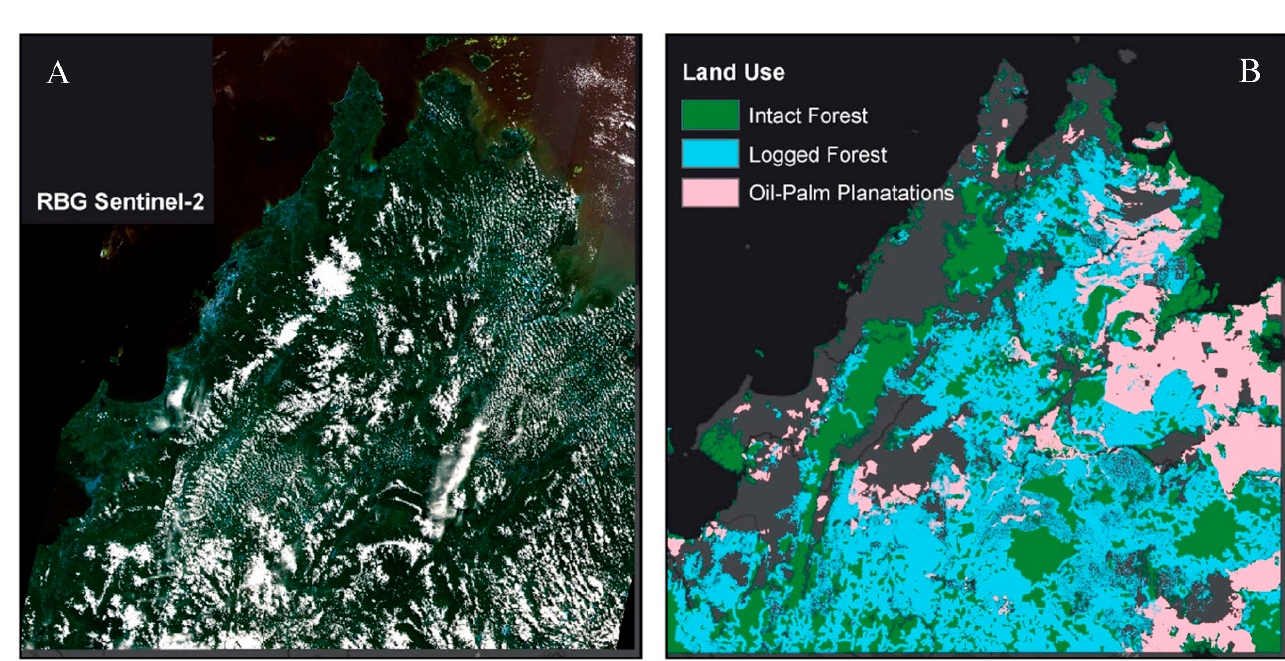
Figure A1. ( A ) Map of the Sentinel-2 observation, as seen through a true visible range composite image, over the study area in Sabah, Malaysia, on the 9th of July 2017 after atmospheric corrections. ( B ) Map of the three land-use classes within the Sabah study area used for analysis. Table A1. Descriptive statistics of elevation and slope observed between plots across land-use types. Data is derived from digital elevation models observed by the 30 m spatial resolution Shuttle Radar Topography Mission (SRTM).